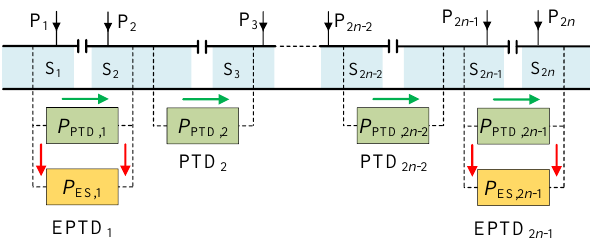
Figure 12. The simplified electrical description for RBE utilization.